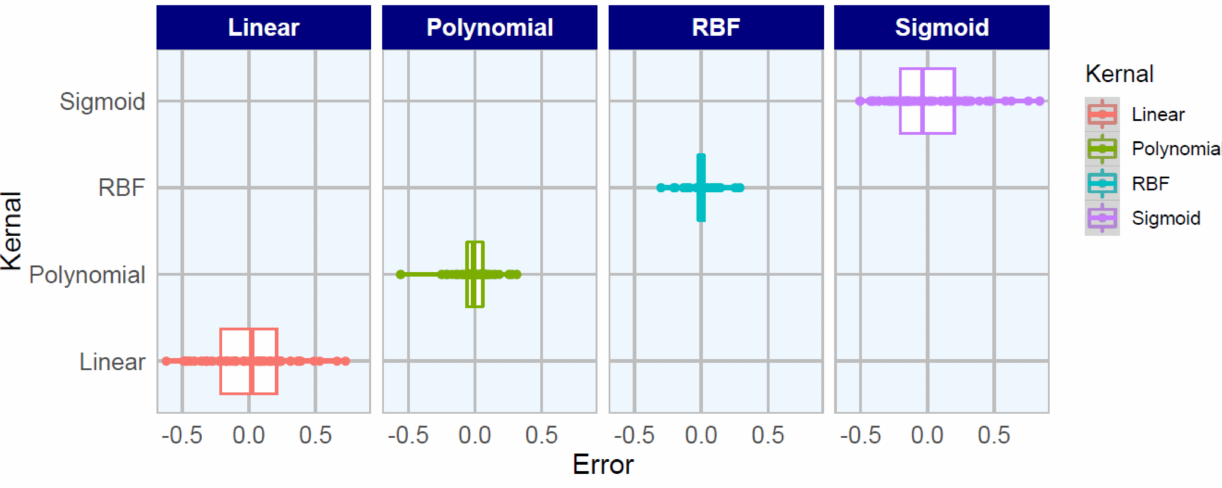
Figure 12. The error changes of the developed models for simulation of